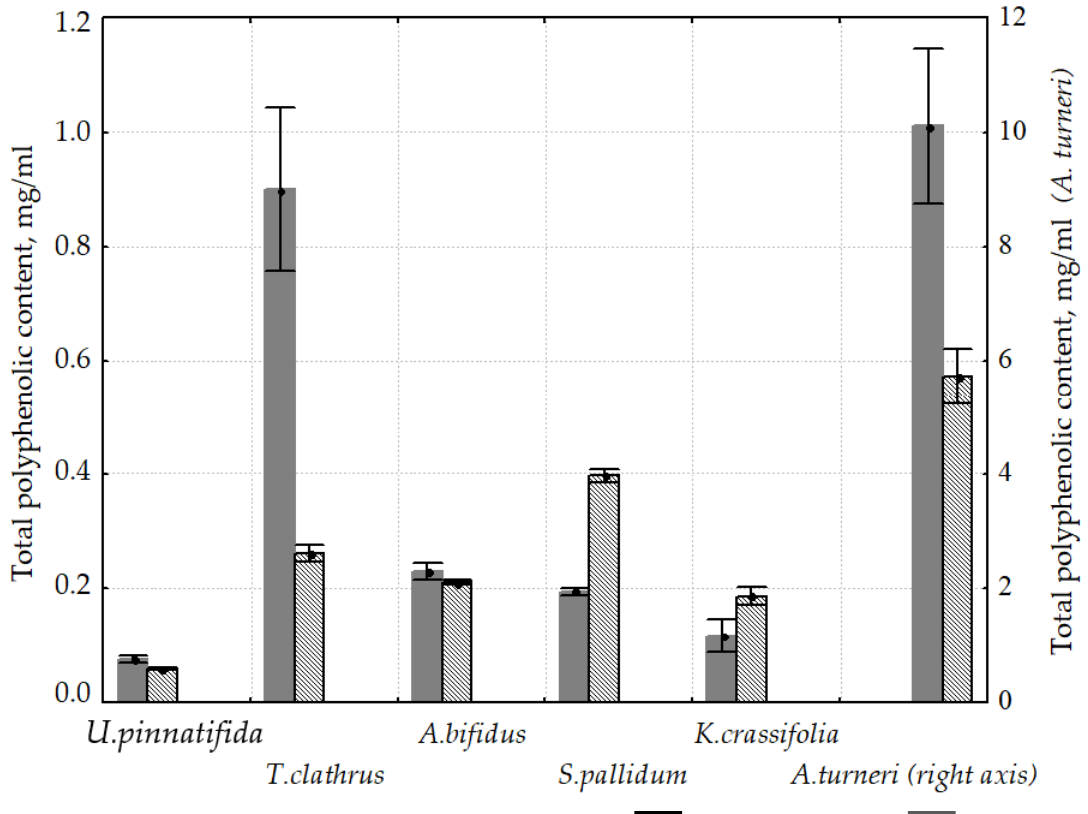
Figure 1. Total polyphenolic content in brown algae water ( ) extracts and ethanol ( ) extracts. Right axis—date for A. turneri .